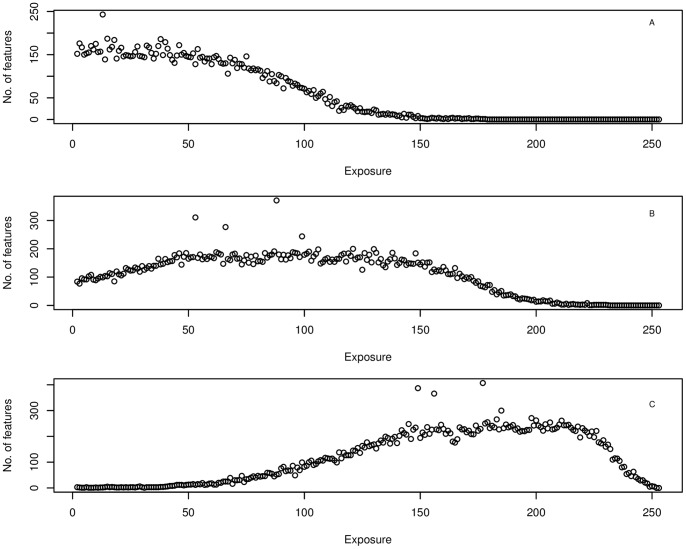
Exposure distribution curves.Exposure distributions under three different inflow angles, that is 5° (A), 20° (B) and 45° (C). An exposure value of 0 indicates sheltered conditions, whereas higher values indicated an increase in exposure. The number of different features refers to the number of 50 m×50 m squares on the DEM.